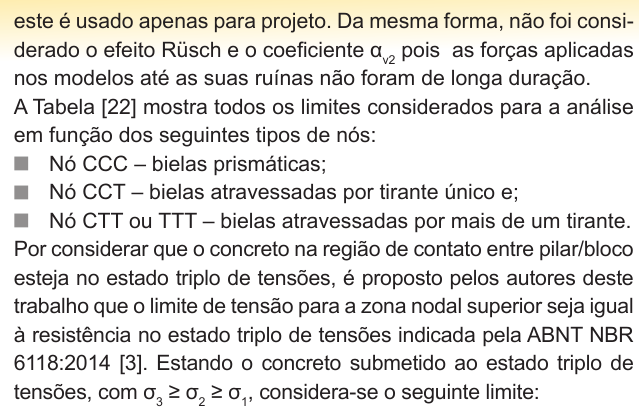
adaptado de Fusco c,Amp,